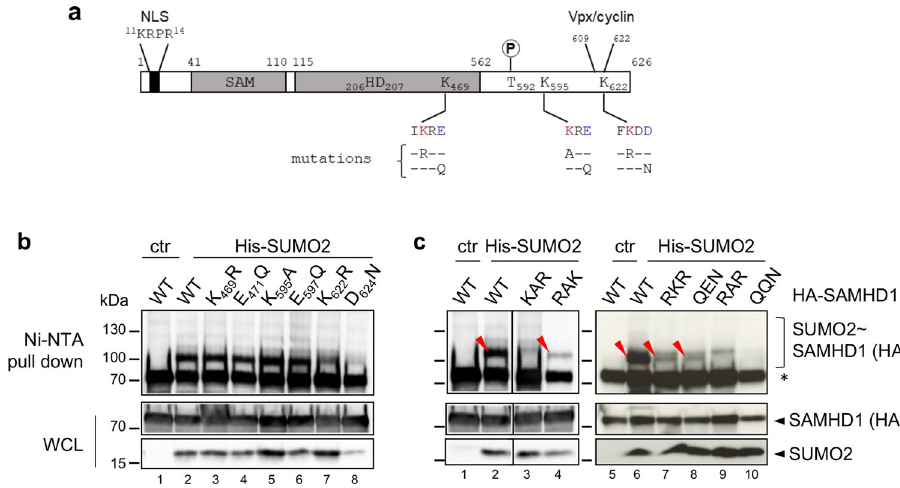
Fig. 2 Residues K469, K595, and K622 are major SUMO conjugation sites of SAMHD1. a Schematic representation of human SAMHD1 showing the nuclear localization signal (NLS), Sterile Alpha Motif (SAM) and Histidine/Aspatate (HD) domains, phosphorylatable T592 residue, and the C-terminal binding site for Vpx/cyclin A2. The position of the three putative SUMO consensus motifs is indicated, with the SUMO acceptor K and the acidic amino acids colored in red and blue, respectively. Residue substitutions are described below each SUMOylation site (mutations were done on single or multiple sites as described in the text). b HEK 293T cells overexpressing HA-SAMHD1 WT or single-site or c multiple SUMO-site mutants, Ubc9 and His-SUMO2 were processed as in Fig. 1a. Lanes 1 to 4 in panel C are derived from the same blot but were not adjacently loaded. WCL whole-cell lysate. *, nonspeci fi c binding of unmodi fi ed SAMHD1 on Ni-NTA beads. The red arrowheads indicate the ~100 kDa band corresponding to mono-SUMOylated SAMHD1 species. Results of one representative experiment are shown ( n ≥